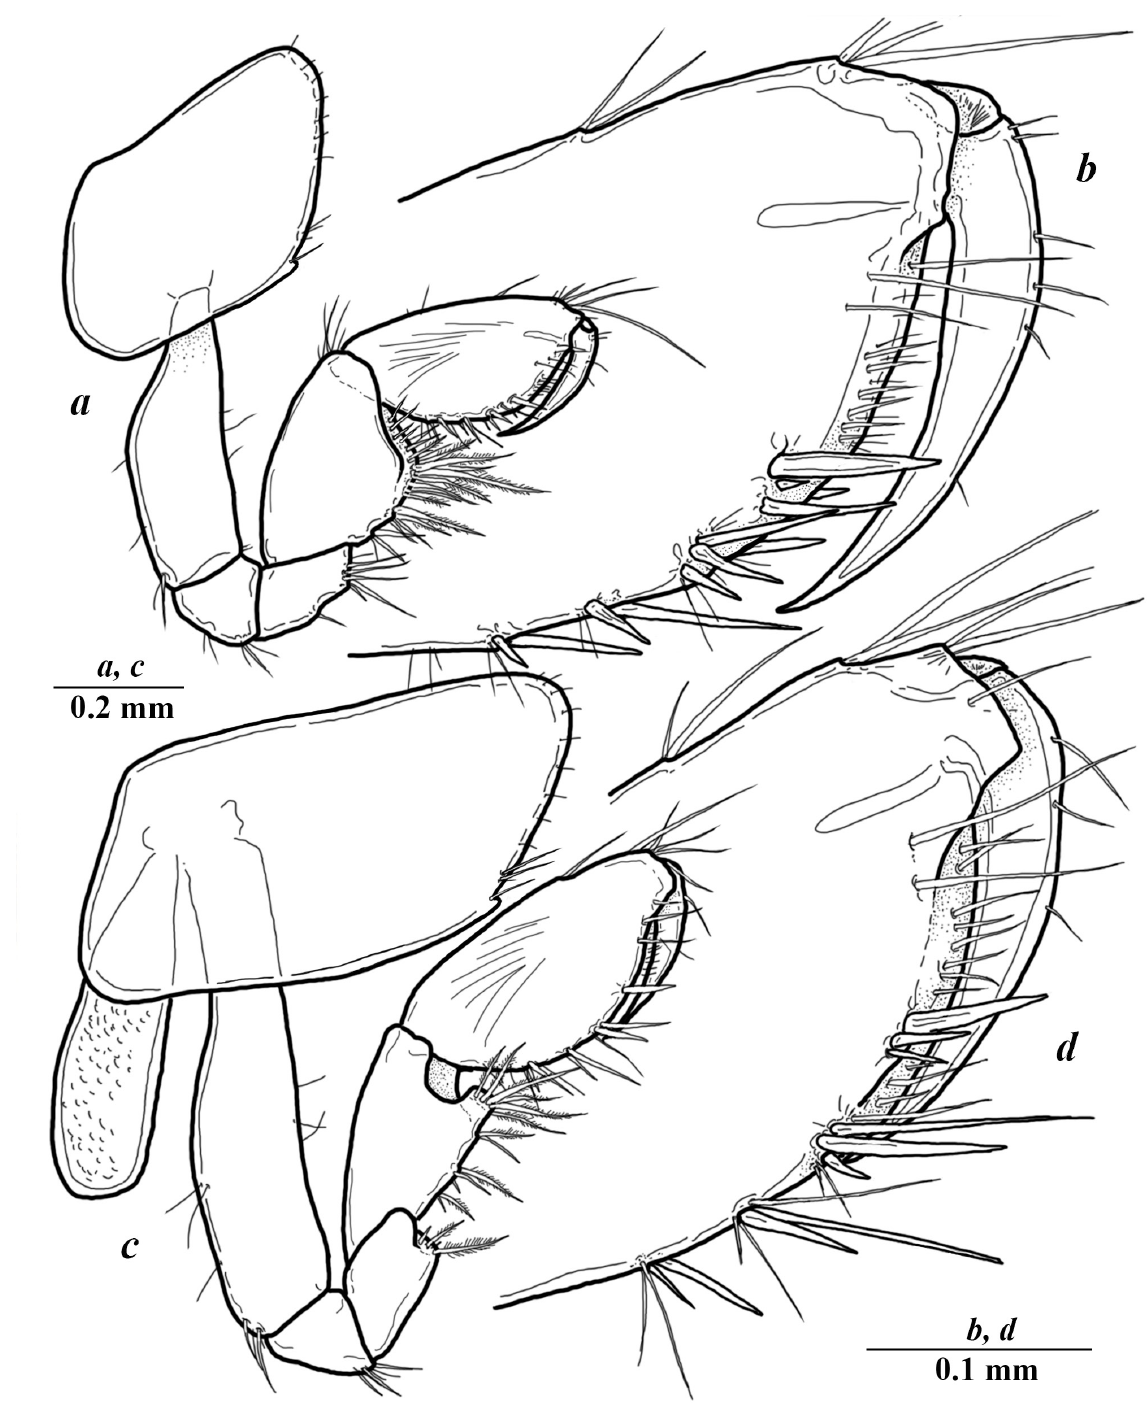
Fig. 3. Pleusymtes actiniae sp. nov., paratype, ♂ (ZMMU Mb-1223). a . Gnathopod I. b . Distoventral palmar margin of propodus (chela) of GnI. c . Gnathopod II. d . Distoventral palmar margin of propodus (chela) of